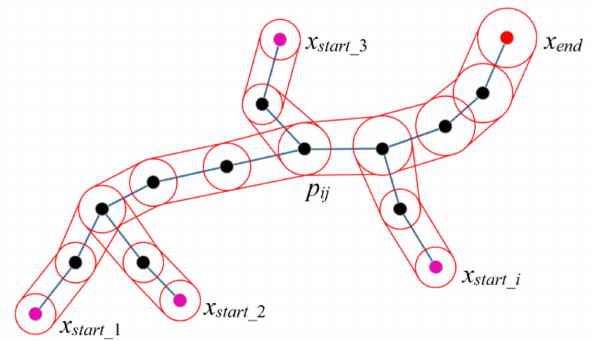
Figure 3. Prior path space.